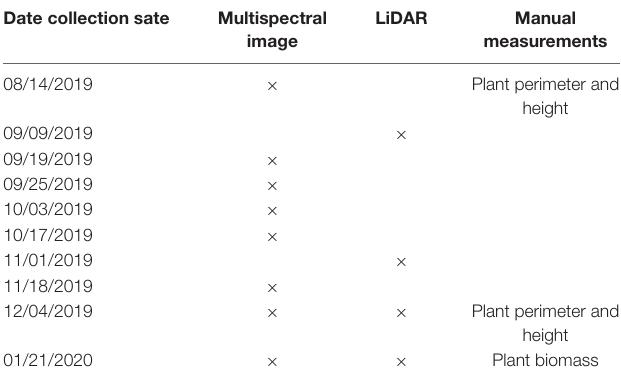
TABLE 1 | UAV data routing observations and manual measurements in the growing season.